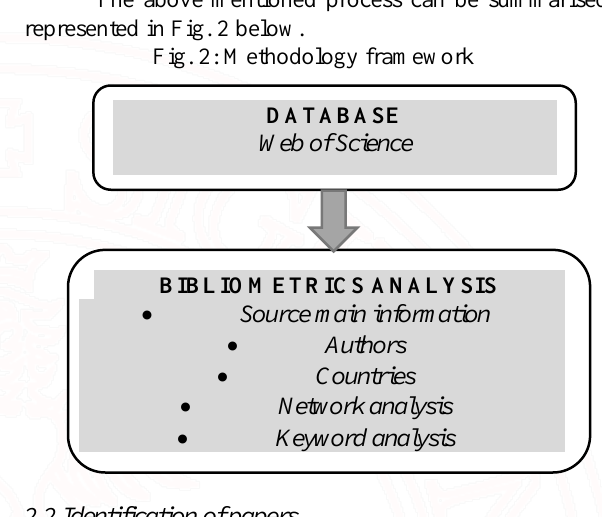
Fig. 2: Methodology